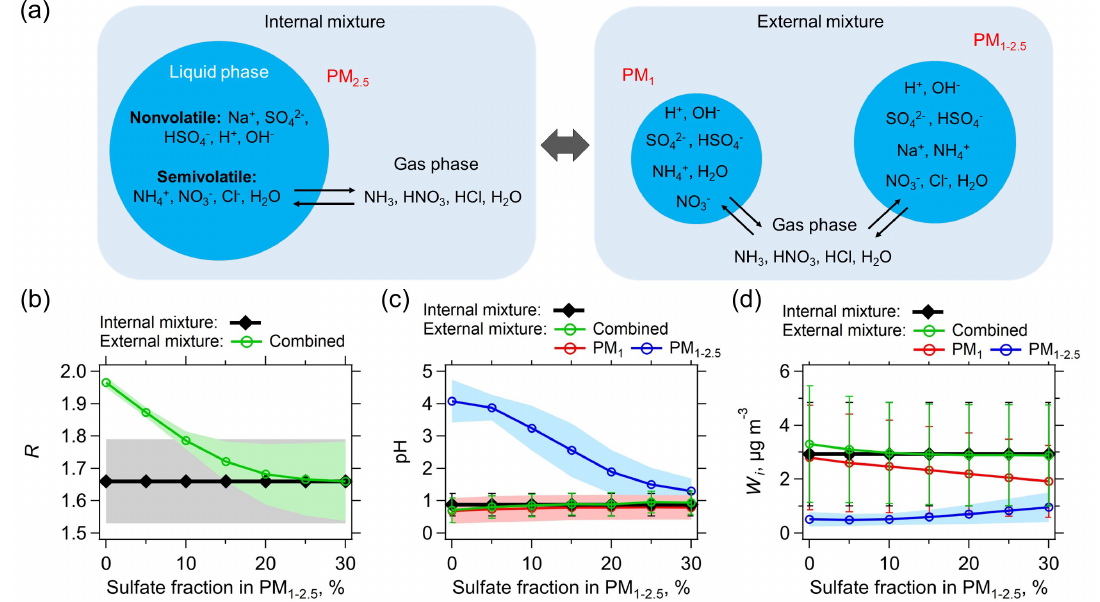
Figure 7. (a) Schematic of assumed internally and externally mixed aerosols. NVCs (here represented by Na + ) are all assumed in PM 1 − 2 . 5 for the external mixing case. The two externally mixed aerosol groups (PM 1 and PM 1 − 2 . 5 ) are in equilibrium with the same gases. The internal mixed case has bulk PM 2 . 5 compositions (PM 1 + PM 1 − 2 . 5 ) together with gases as model input. The predicted molar ratio ( R ), pH, and liquid water ( W i ) of the internally and externally mixed aerosols are summarized in (b) , (c) , and (d) , respectively. The x axis is the sulfate (mass) fraction assumed in PM 1 − 2 . 5 , with the remaining sulfate in PM 1 . For the analysis shown here only data for which measured Na + was above the LOD are utilized. Lower Na + concentrations require smaller fractions of SO 2 − in the PM 1 − 2 . 5 range for agreement with the 4 bulk analysis (e.g., 5% for the PILS-IC Na + LOD of 0.07µgm − 3 ). Standard deviations of the data are shown as error bars or shaded